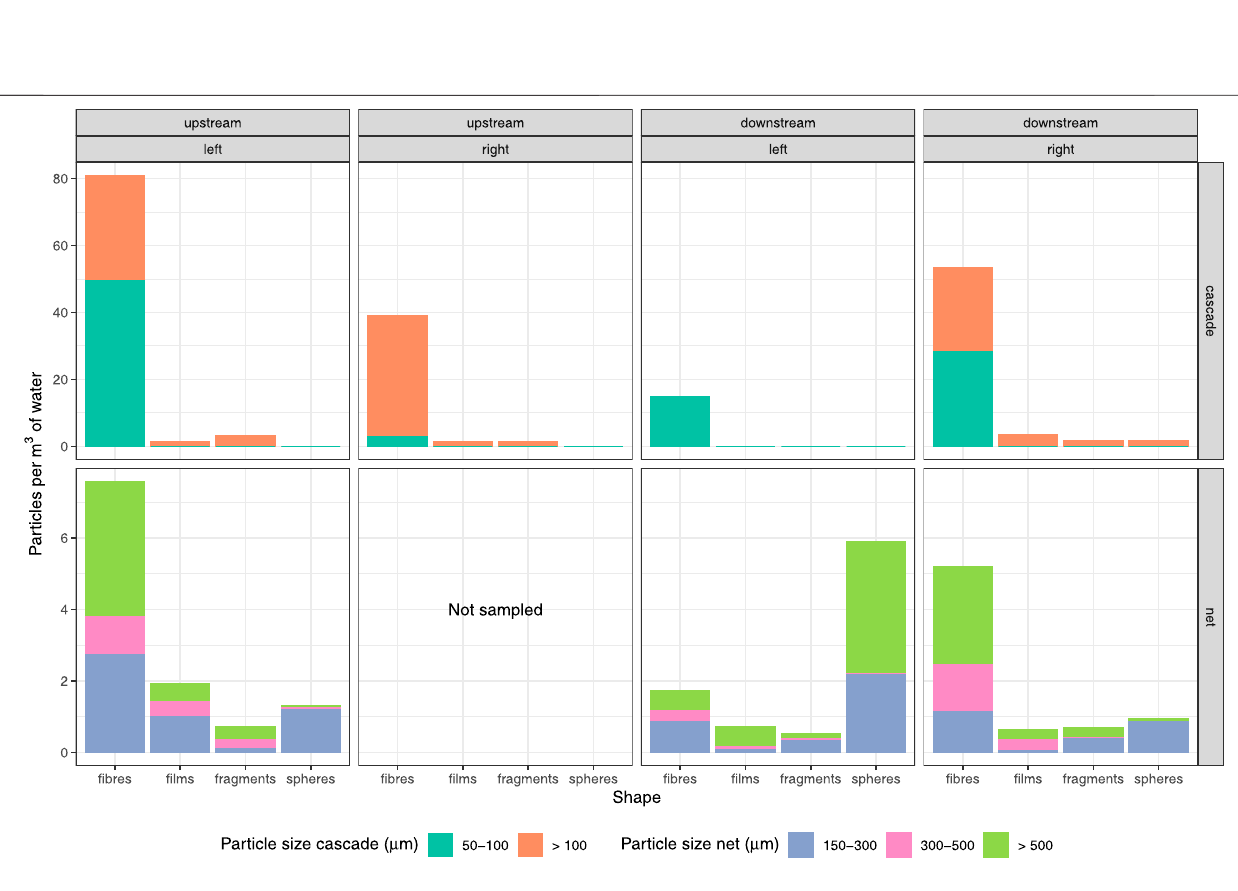
Frontiers in Environmental Science |